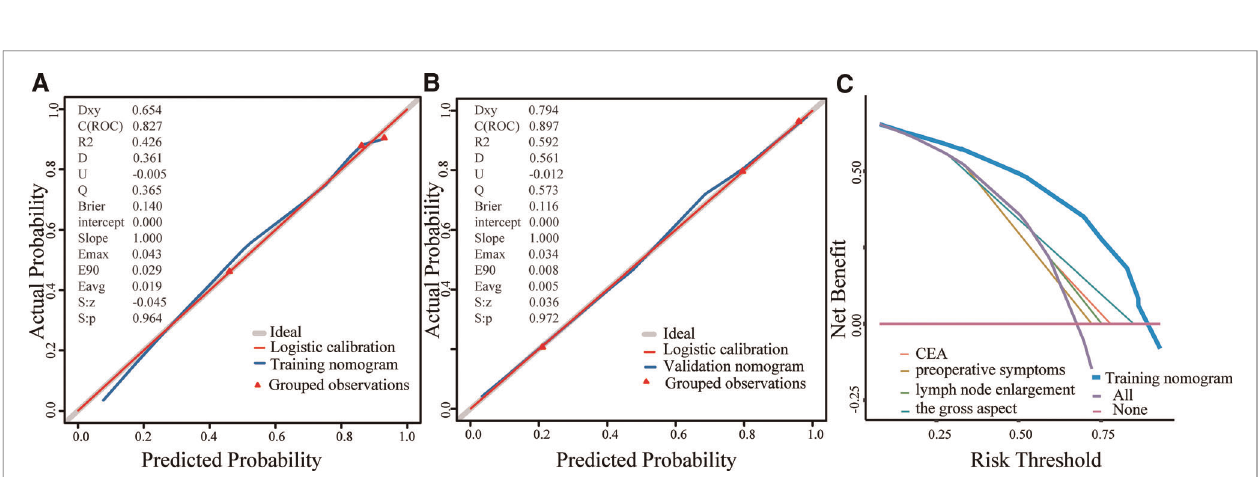
FIGURE 3 | A , Validity of the predictive performance of the nomogram in estimating the risk of occult advanced ESCC presence in the training cohort (n=426). B , Validity of the predictive performance of the nomogram in estimating the risk of occult advanced ESCC presence in the validation cohort (n = 172). C , Decision curve for prediction of occult advanced ESCC. Pink line: assume no patient will have occult advanced ESCC; Purple line: assume all patients will have occult advanced ESCC; The x-axis and the y-axis were the threshold probability and the net bene fi t,